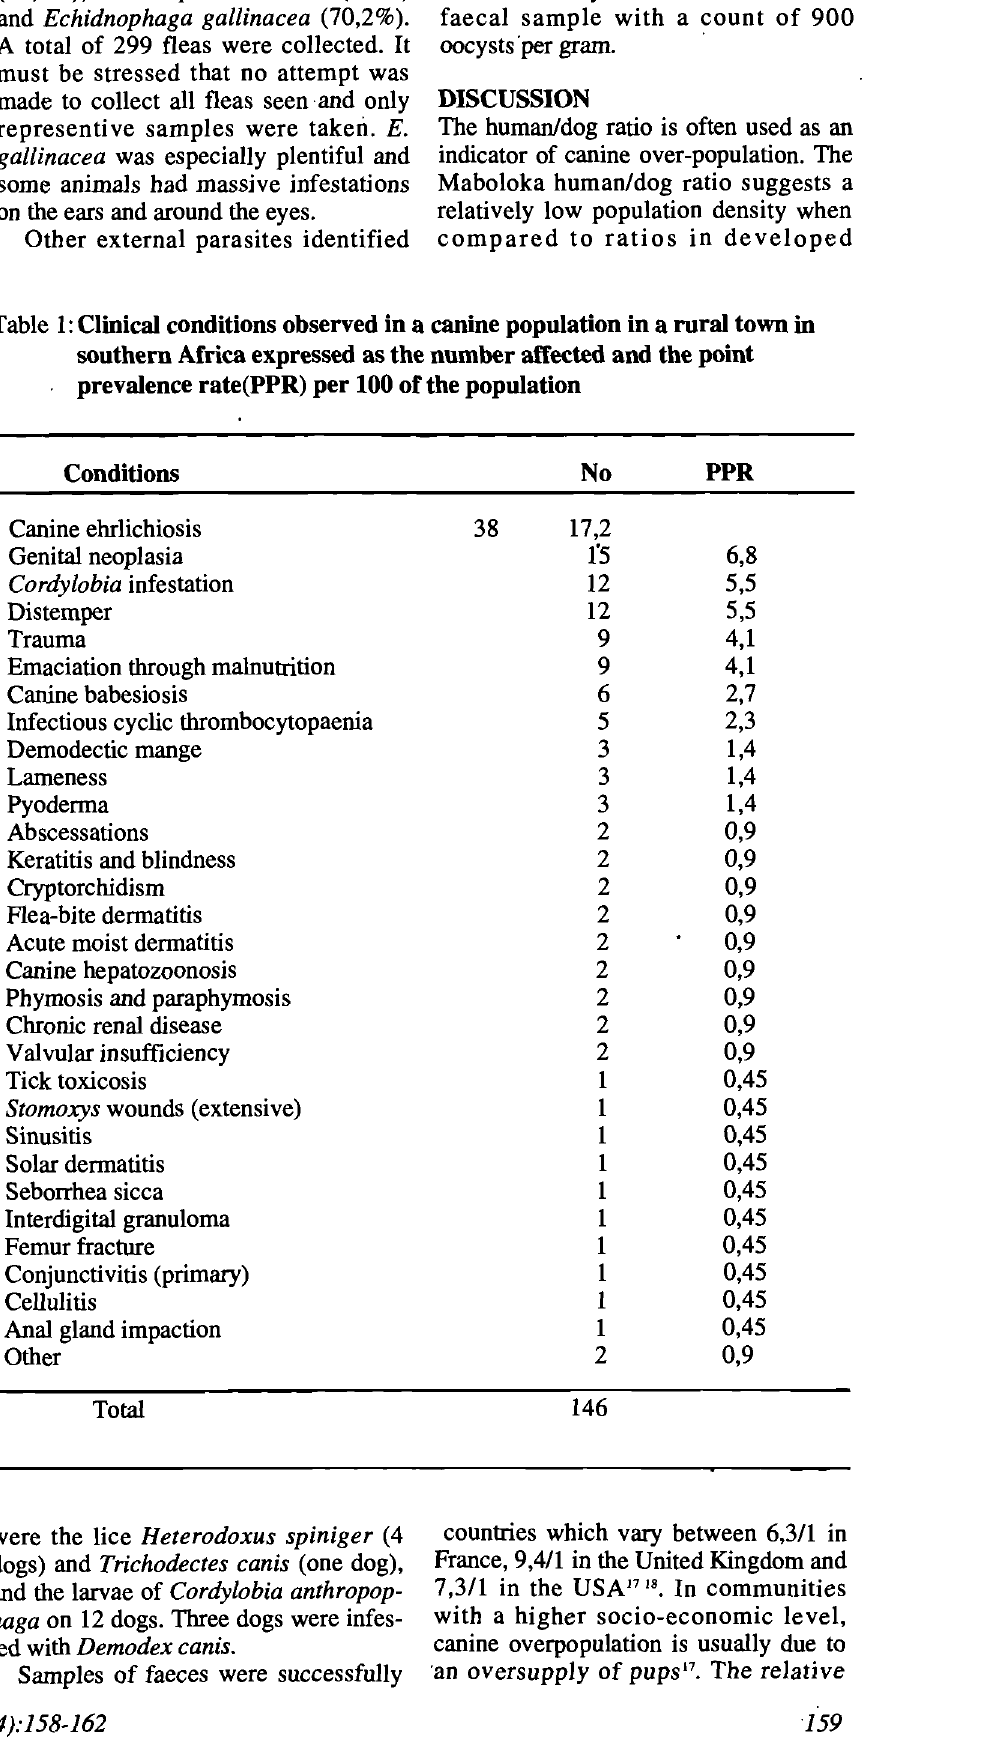
Table 1: Clinical conditions observed in a canine population in a rural town in southern Africa expressed as the number affected and the point prevalence rate(PPR) per 100 of the